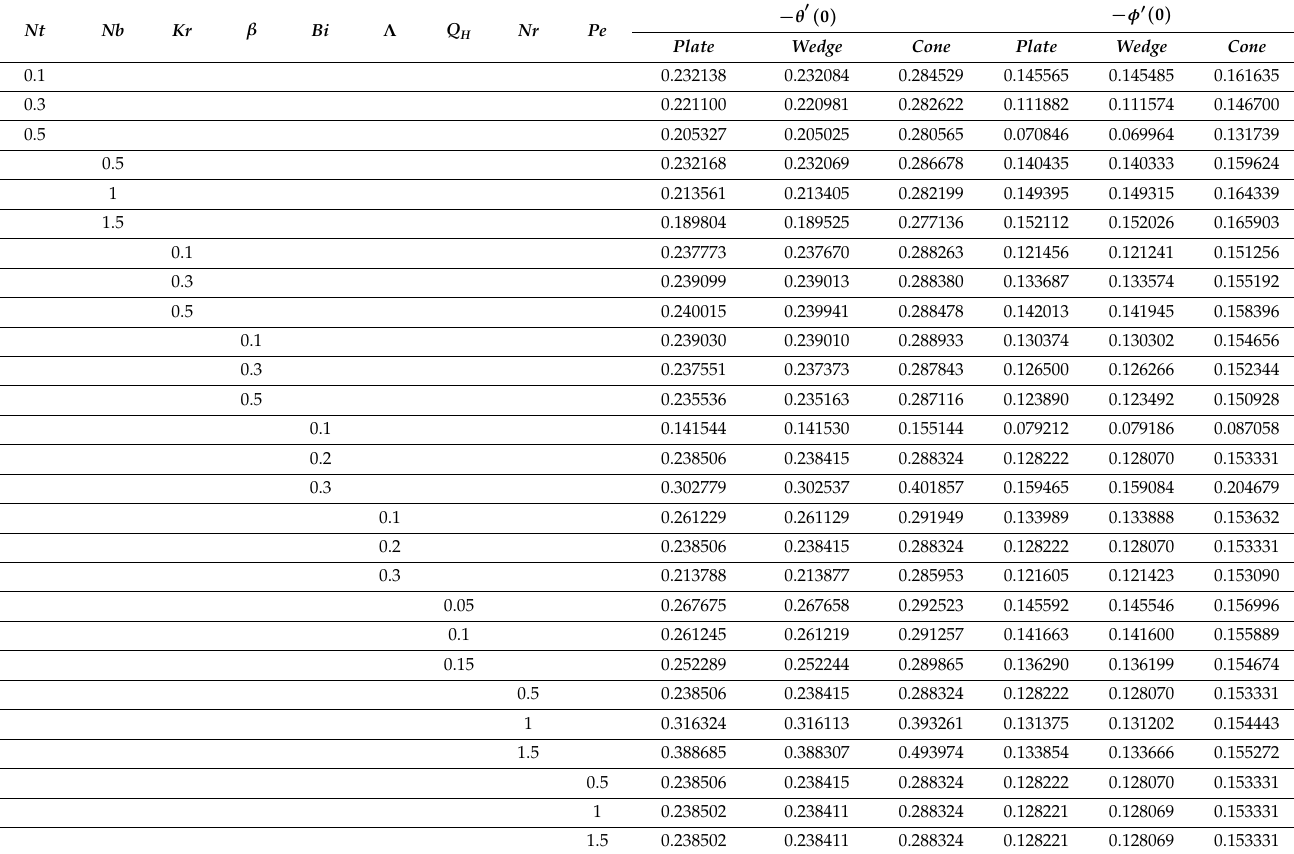
Table 2. Variation in θ (cid:48) ( 0 ) and φ (cid:48) ( 0 ) for flow over a cone, wedge, and